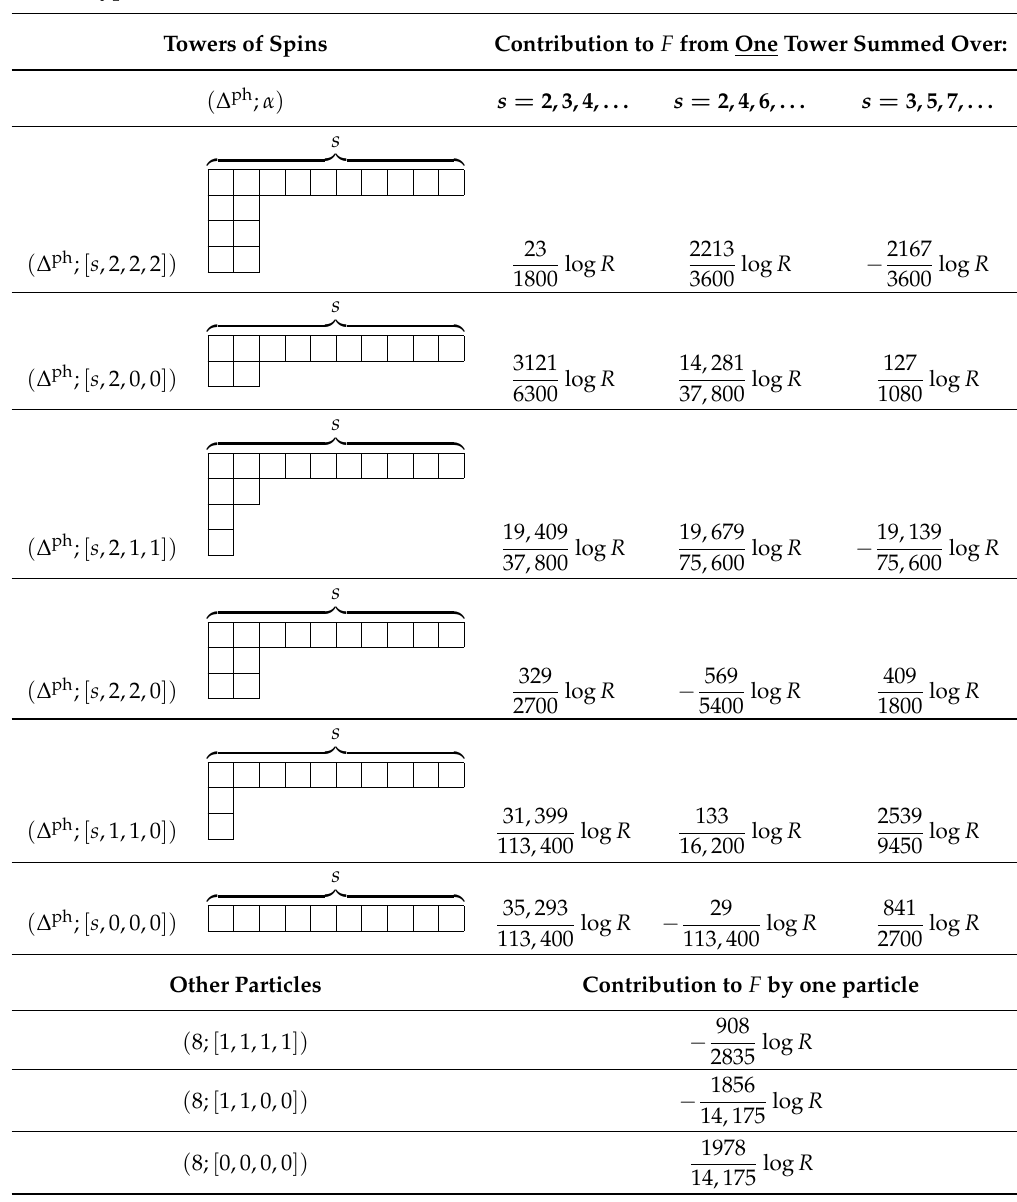
Table A7. Results for Type C theory in AdS 9